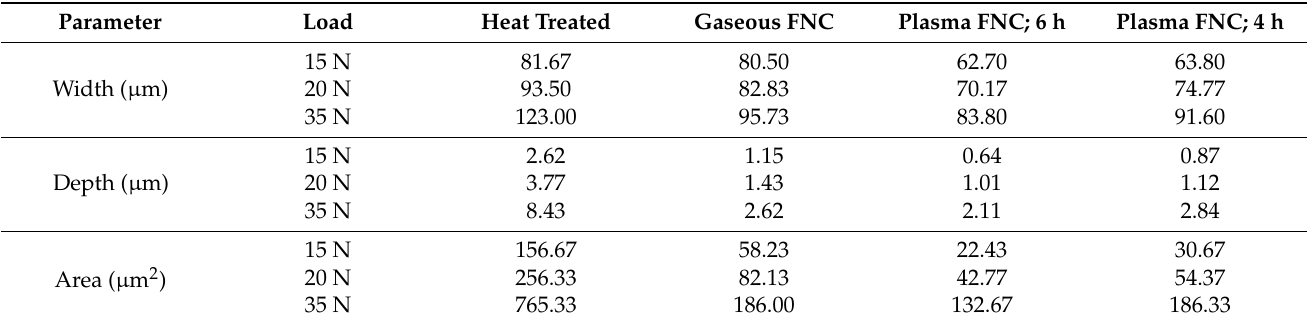
Table 4. Values of cross-sectional profile parameters.